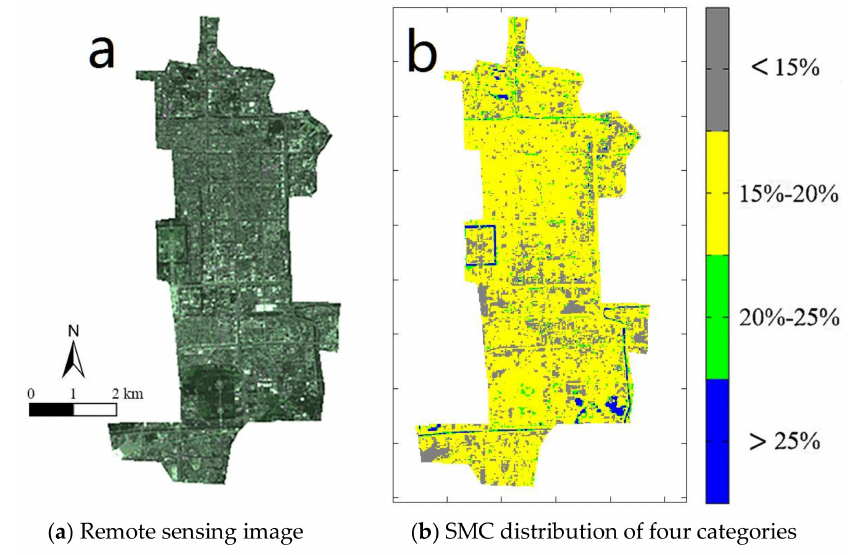
Figure 7. ( a ) The remote sensing image and ( b ) SMC distribution in the Dongcheng